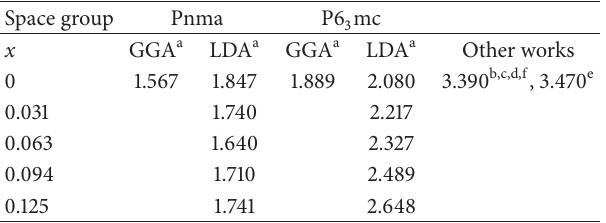
Table 3: Calculated band gap (eV) for Ga 1−𝑥 Al 𝑥 N alloy. Space